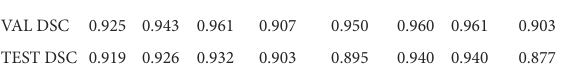
TABLE 2 DSC values for each of the eight physiologically relevant tissue classes, averaged over four runs, computed on the validation set and the held-out test set.